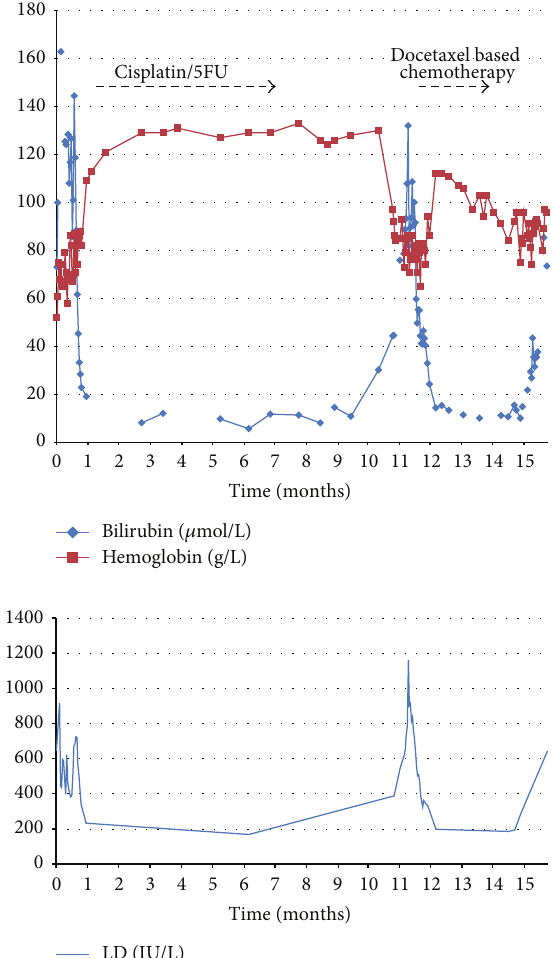
Figure 3: Hemoglobin, total bilirubin, and lactate dehydrogenase levels